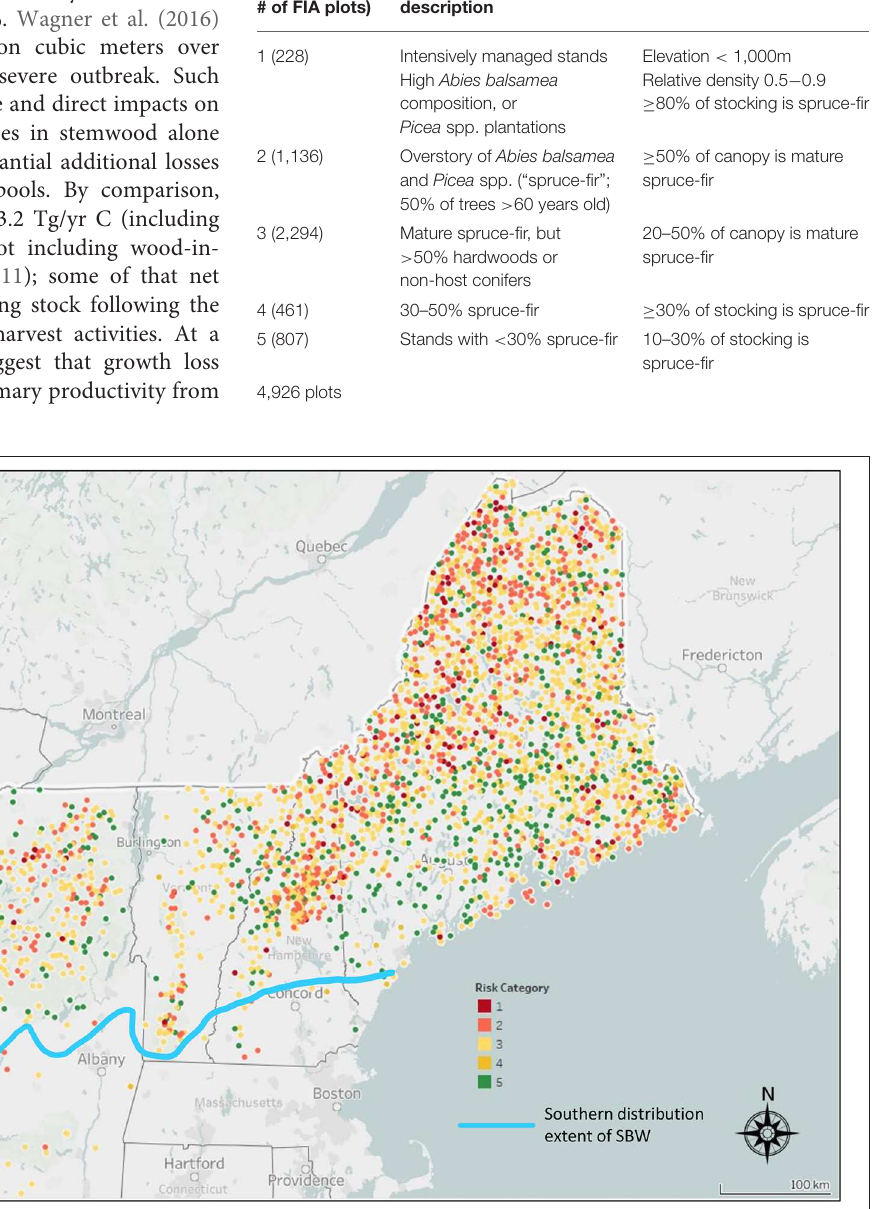
Frontiers in Forests and Global Change |